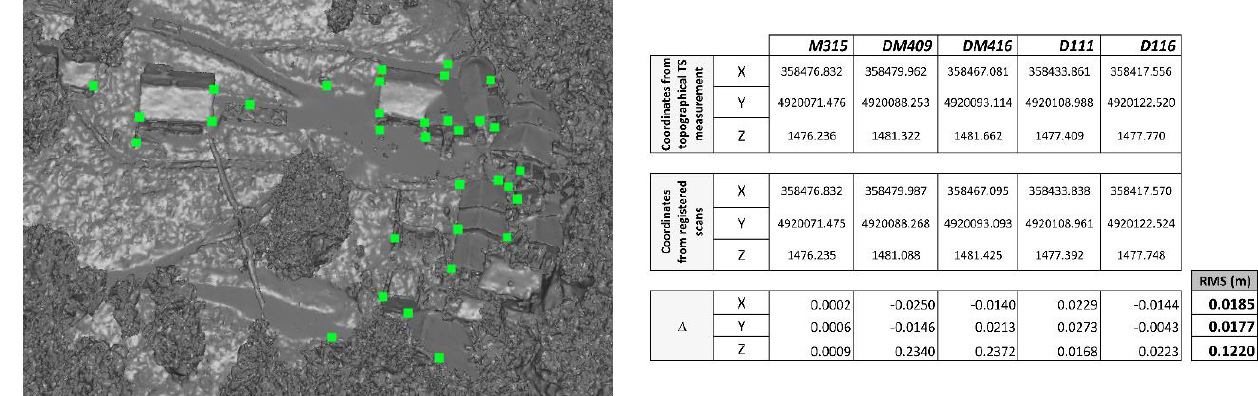
Figure 13. Position of GCP measured on the achieved UAV model as further constrain in terrestrial scans registration